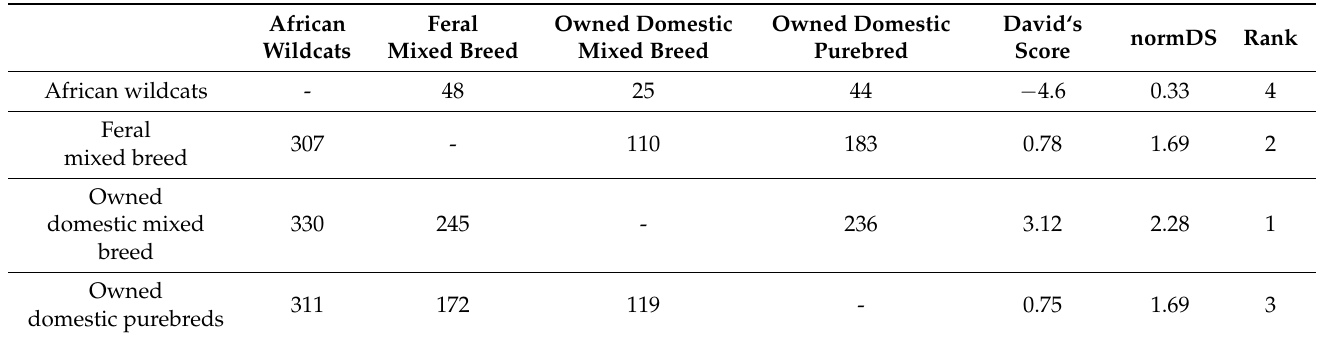
Table 3. Comparison of the four nonmanipulated groups calculated from David’s